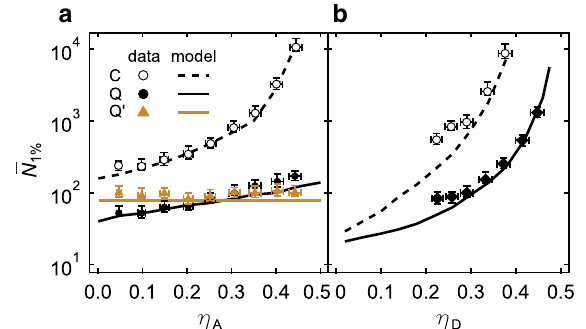
Fig. 4 Robustness of quantum parity learning to noise. Number of queries N 1 % for p ¼ 0 : 01 for variable readout error η of ancilla a or data b qubits, with n = 3. η is tuned by setting the readout power of the corresponding qubit(s). Empty ( solid ) circles correspond to the analog C ( Q ) solver. a , N 1 % diverges for η A → 0.5 for C , while it stays limited for Q . When η A \ 0 : 25 , it is preferable to ignore V A altogether ( Q ′ , triangles). b Whereas both C and Q are severely affected by a noisy data register, Q remains superior and the performance gap increases with η D . Results are out of scale for C and η D \ 0 : 4 . The corresponding N 1% are not computed, due to the processing time of several hours that would be required. See Methods for